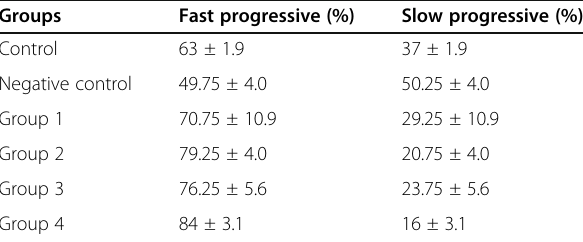
Table 3 Representation of sperm progressive assessment Groups